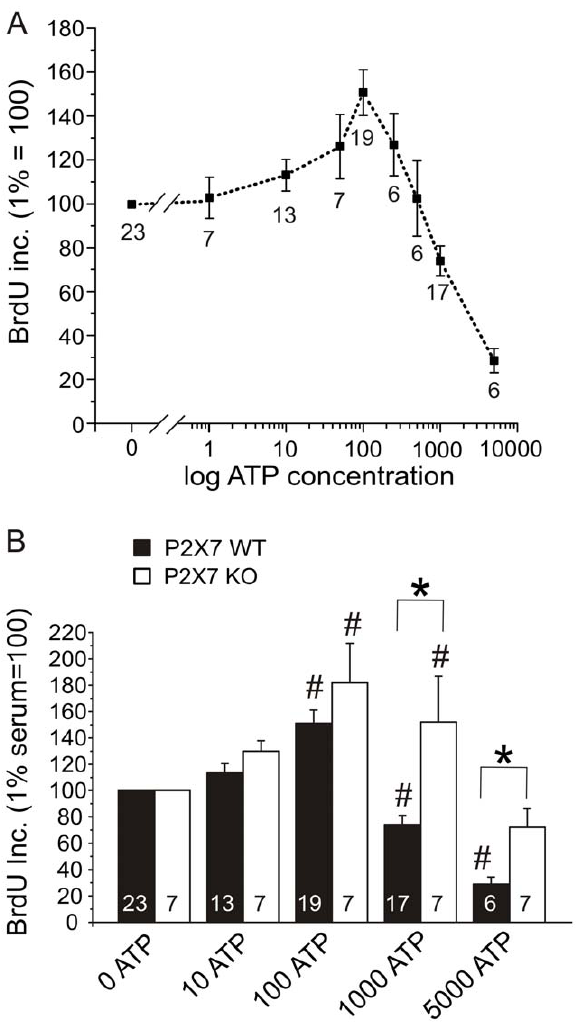
Figure 7. ATP can stimulate life and death in PSCs. A. Effect of ATP in growth medium with 1% serum on BrdU incorporation in WT PSCs (n=6–23). B. Effect of selected ATP concentrations ( m M) on BrdU incorporation in WT and KO PSCs both normalized to their respective 0 ATP controls (n=7–23). BrdU incorporations were normalized to 1% serum conditions for the respective cell type. Significant difference (P , 0.05) from respective controls ( # ) and between WT and KO (*) is